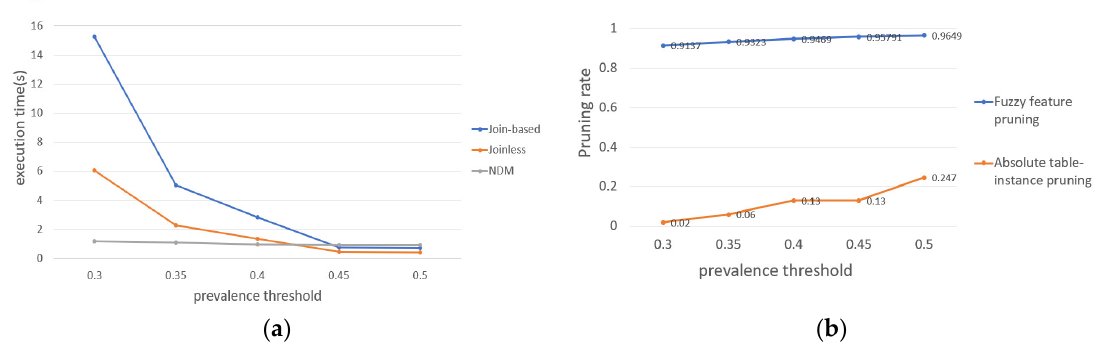
Figure 11. ( a )Effect of the prevalence threshold; ( b ) Pruning degree for the two